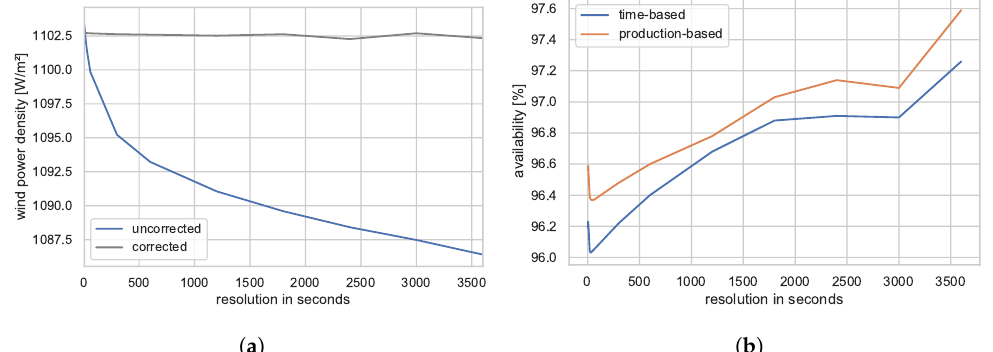
Figure 3. Effect of different data resolutions on ( a ) (wind power density) the calculation of an average wind power density and ( b ) (availability) availability metrics in the case that downtimes are solely identified based on